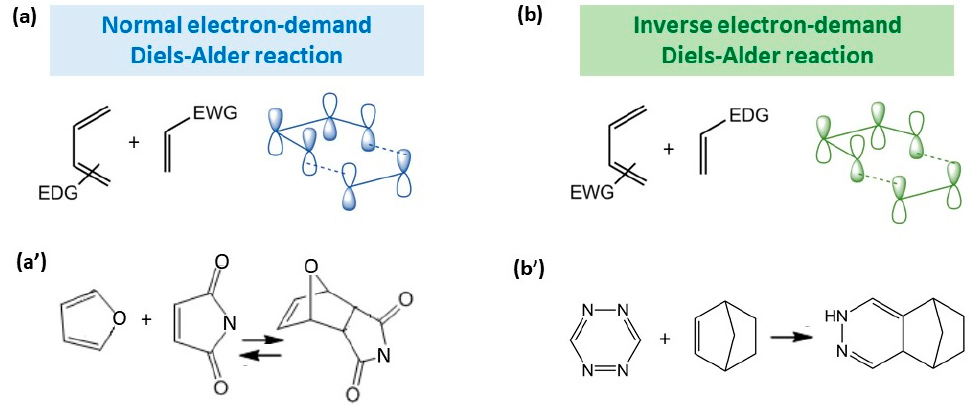
Figure 2. Illustration of the orbital interactions in normal ( a ) and inverse ( b ) electron-demand Diels– Alder reactions and the most common examples of these reactions for normal ( a’ ) and inverse ( b’ ) electron-demand Diels–Alder reactions.